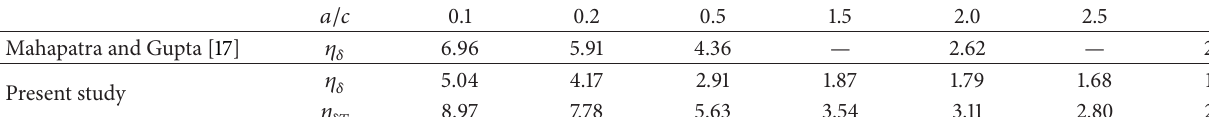
Table 2: Values of 𝜂 𝛿 and 𝜂 𝛿𝑇 for several values of 𝑎/𝑐 with Pr = 0.5 and 𝜆 = 1 .